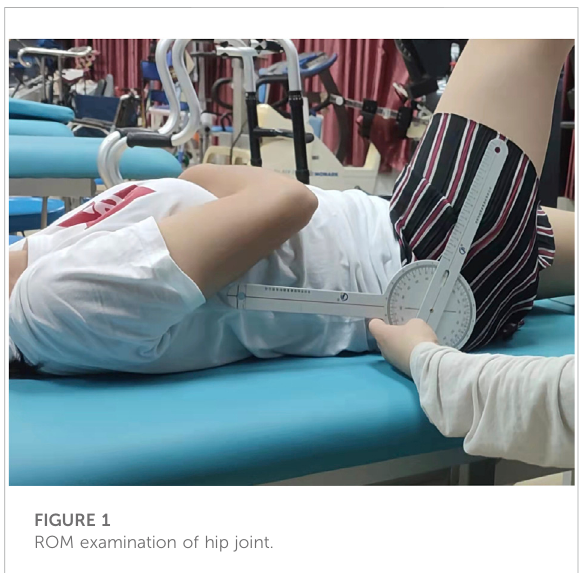
FIGURE 1 ROM examination of hip